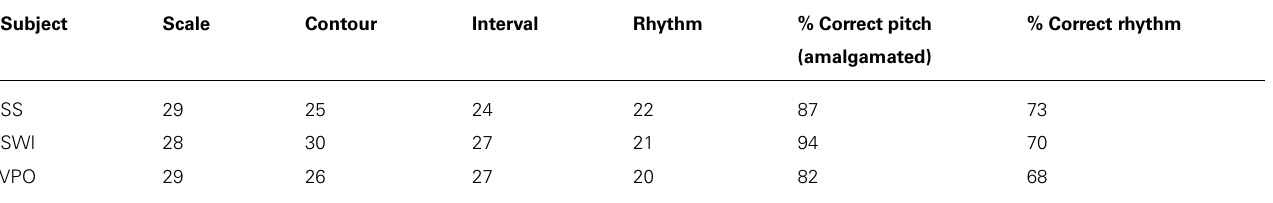
Scores below 23 are considered to indicate impairments.